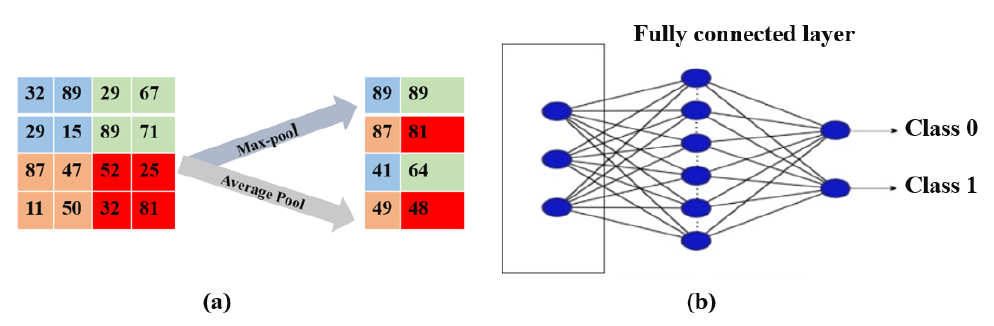
Figure 4. Demonstration of ( a ) max-pooling and average-pooling, and ( b ) classification